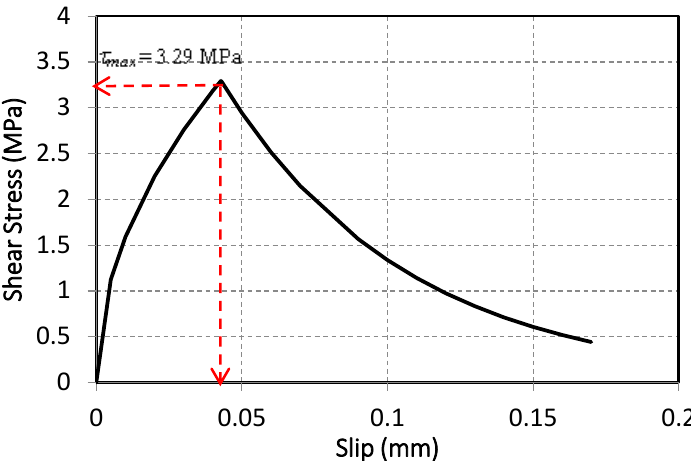
Figure 3. Typical interfacial stress–slip model used in ANSYS and ABAQUS.